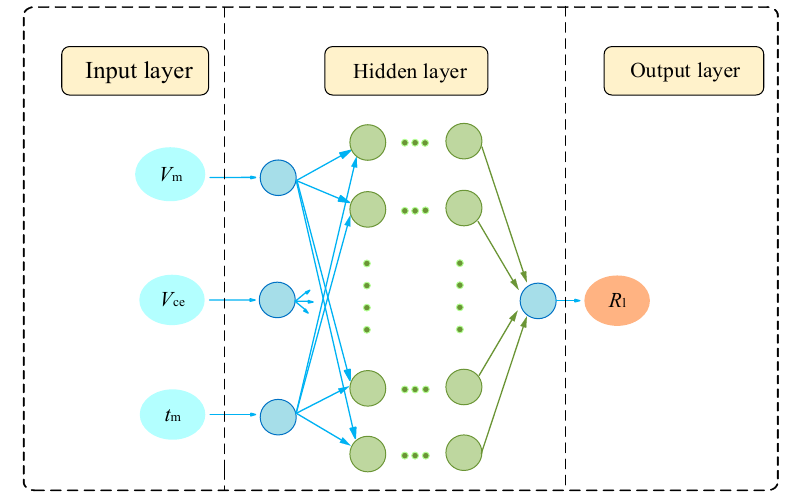
Figure 16. Structural diagram of artificial neural network (ANN).